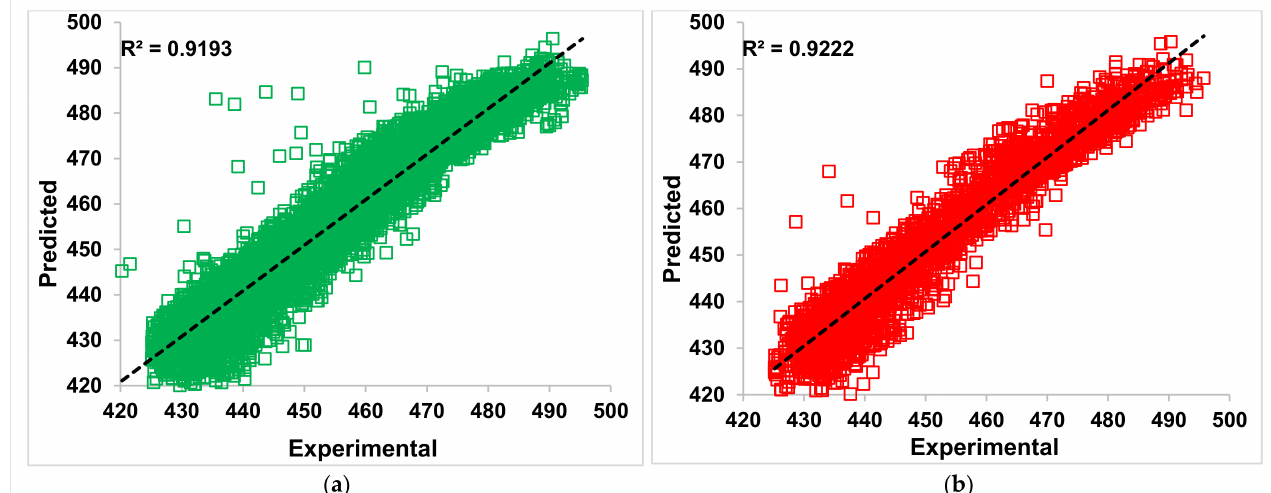
Figure 14. Polynomial regression-based SVR (SVR Poly.) algorithm used for ( a ) Training and ( b ) testing of PEO data. In Figure 15, a relative variation of CCPP output energy data from experimental recordings and computed readings using SVR (LR), SVR (RBF), and SVR (Poly.) algorithms is shown. For demonstration, only the first 20 data points are chosen arbitrarily. The circled marker data scattered in the plot shows the experimental values for reference. The reaming empty square boxes show the respective readings computed during the training session of the three SVR algorithms. The SVR (RBF) for most data points completely overlapped, while the other two algorithm readings are seen to deviate but still slightly match the trend of actual values. In Figure 16, the predictions provided by the SVR algorithms during the testing session are comparatively provided. Each vertical line in the figure represents a single data point on which the values from the experiment and SVR algorithms lie. The actual values in an empty brown circle lie in the mid of the SVR readings, majorly predicted data. The closer values seen are from empty yellow triangles, i.e., by SVR (RBF) algorithm. Figure 17a,b the training output computed, and the prediction made from the trained algorithm, respectively. SVR (LR), SVR (RBF), SVR (Poly.), and RidgeCV algorithms are used for comparative analysis. The bars in Figure 17a indicate that the least error is obtained from SVR (RBF). However, during testing Figure 17b, RidgeCV and SVR (RBF) have nearly the same error